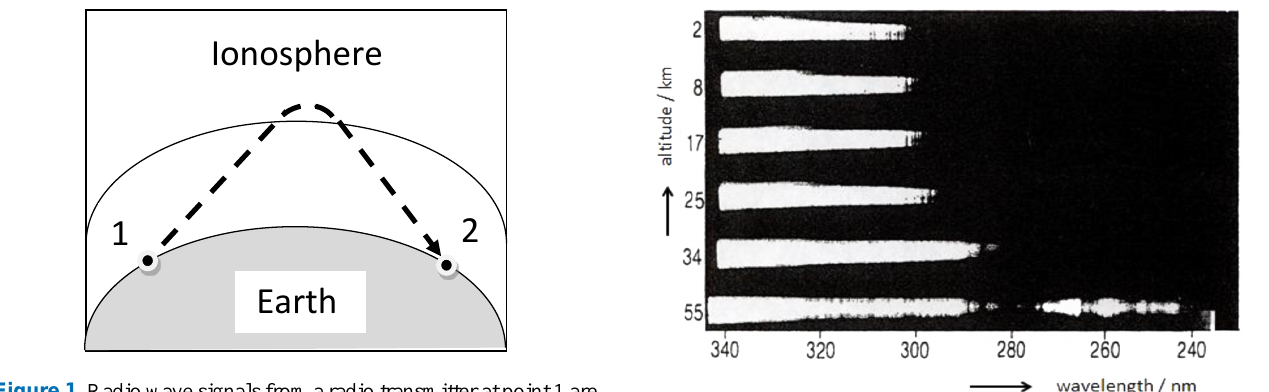
Figure 1. Radio wave signals from a radio transmitter at point 1 are Figure 1: Radio wave signals from a radio transmitter at point 1 are reflected in reflected in the ionosphere and can be detected at point 2 “behind the ionosphere and can be detected at point 2 ‘behind the horizon’ at point 1. Figure 2. First recording of an ultraviolet spectrum on 10 October the horizon” at point 1. 1946 by R. Tousey (Baum et al., 1946; copyright permission granted by the American Physical Radio signal transmission became an important subject of intense exploration and scientific research also for several applications in civil and military fields. In this context investigators developed UV spectrographs with photographic film and artificial light sources recording the violet to the ultraviolet regions beyond the visible (VIS) sunlight spectrum. These techniques allowed also recording the solar radiation in the ultraviolet spectral region. The spectral UV regions are sub-divided in UV-A (380-315 nm), UV-B (315-280 nm), and UV-C (280-200 nm) due to the different biological impacts. Because the UV radiation is absorbed at normal air conditions investigation of the UV-C requires the application of vacuum equipment. Erich Regener as well as his son Victor H. Regener used balloons as a platform for their UV spectrographs to reach atmospheric regions of lower gas pressures. At